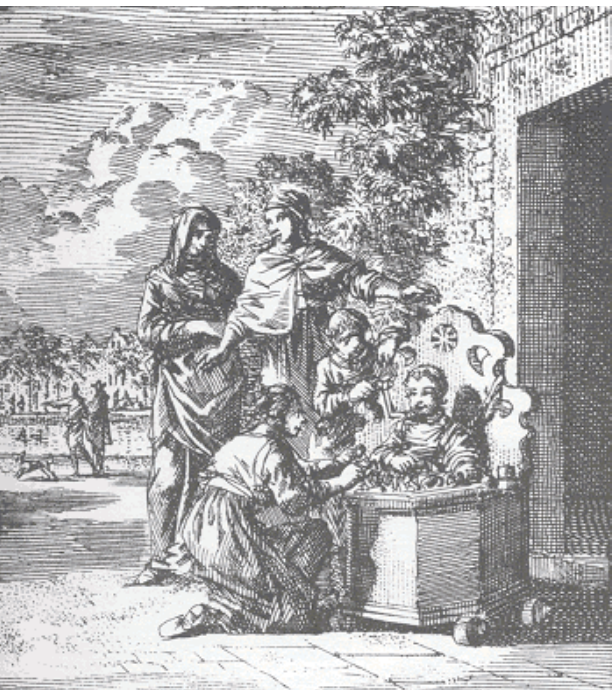
Figure 5. Jan Luyken, “De Speelstoel,” Des Menschen, Begin, Midden en Einde .